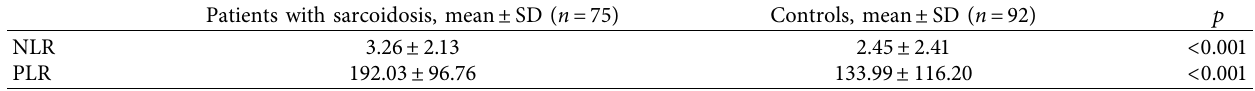
Table 1: The comparison of NLR and PLR between the study and control groups.